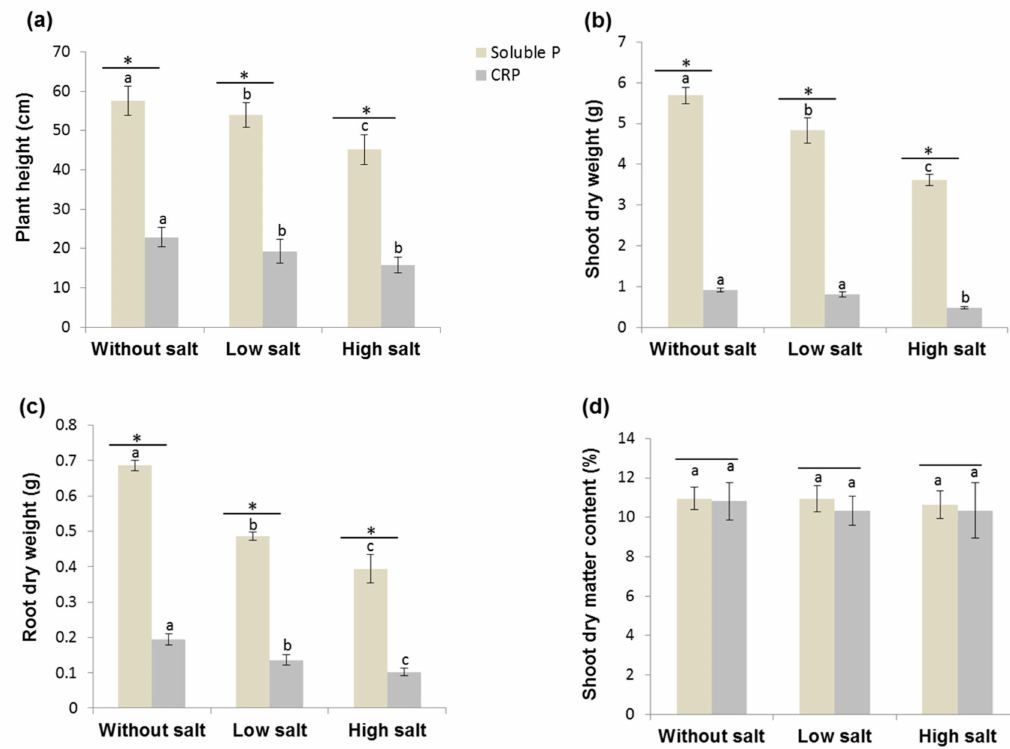
Figure 4. Phosphorus deficiency and salinity a ff ect the growth of tomato plants. E ff ects of phosphorus stress and salinity on ( a ) plant height, ( b ) shoot, and ( c ) root dry weights, and ( d ) shoot dry matter content of control tomato plants (without bacterial inoculation) grown under di ff erent levels of salt stress: without salt (0 ds m − 1 ), low salt stress (8 ds m − 1 ), and high salt stress (12 ds m − 1 ). Peach bars represent plants supplied with soluble phosphate, KH 2 PO 4 , and grey bars plants supplied with hardly accessible phosphate (Cameroonian rock phosphate: CRP). Data shown are the mean of five replications and the error bars represent the standard deviation. Di ff erent letters above the error bars (a,b,c) indicate significant di ff erence between salt stress conditions separately for each phosphate fertilization treatment and stars indicate significant di ff erence between plants supplied with soluble phosphate and plants supplied with CRP under the same salt stress condition ( p < 0.05) using the Tukey HSD